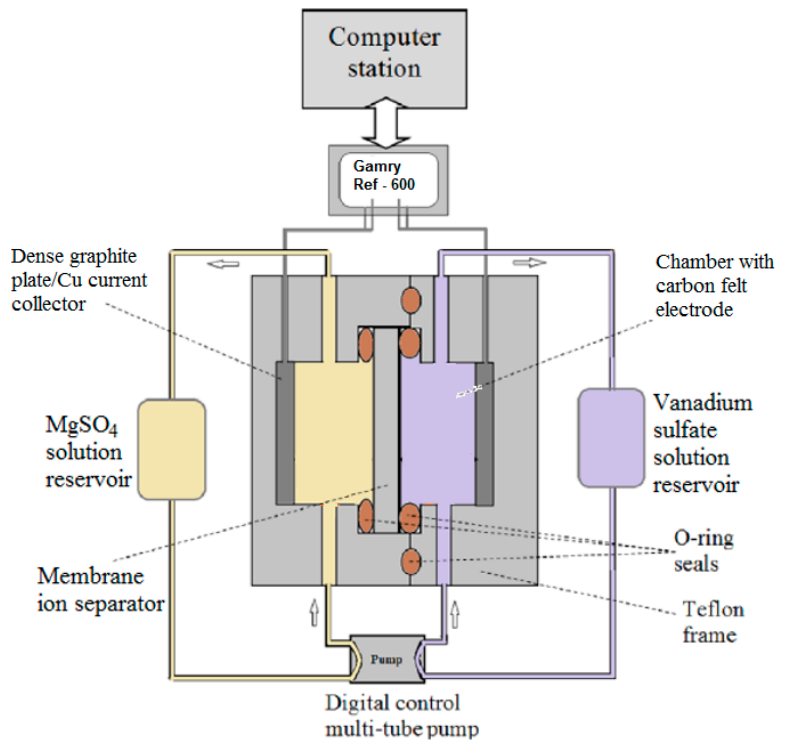
Figure 19. Schematic diagram of the ion diffusion measurement system [16].